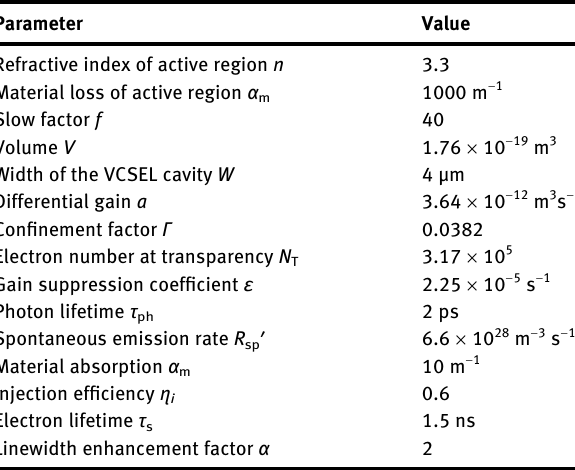
Table  : De fi nitionandnumericalvaluesoftheVCSELparameters[  ].